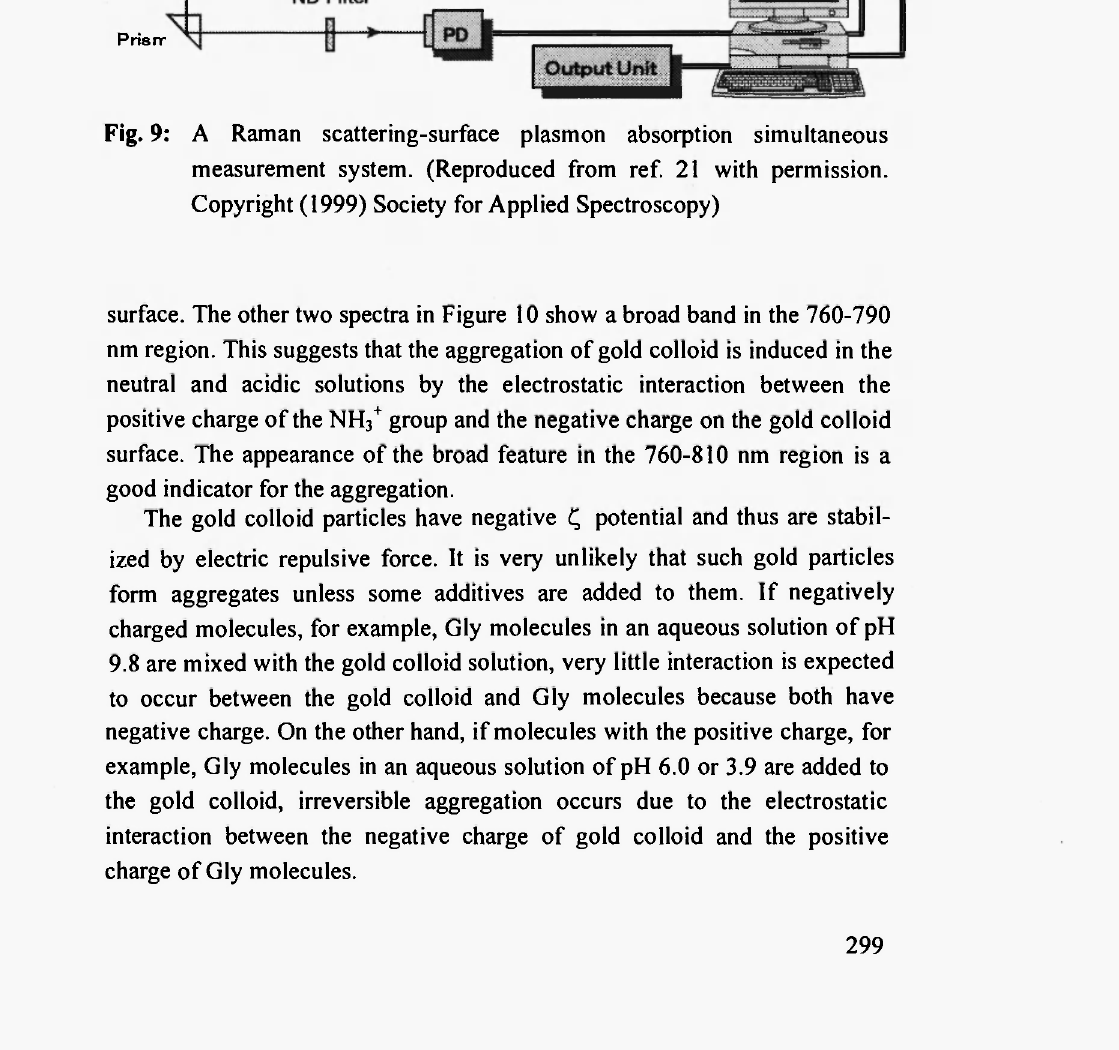
Fig. 9: A Raman scattering-surface plasmon absoφtion simultaneous measurement system. (Reproduced from ref. 21 with permission. Copyright (1999) Society for Applied